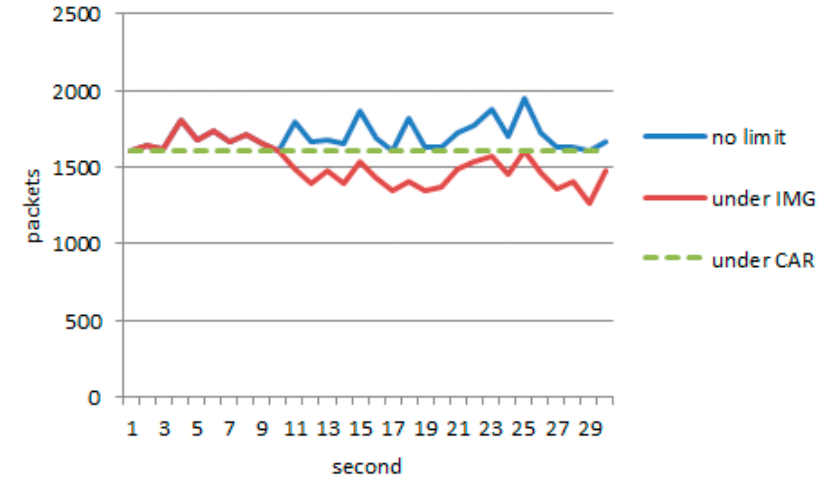
Figure 21. The throughput to the server under IMG (30 s).